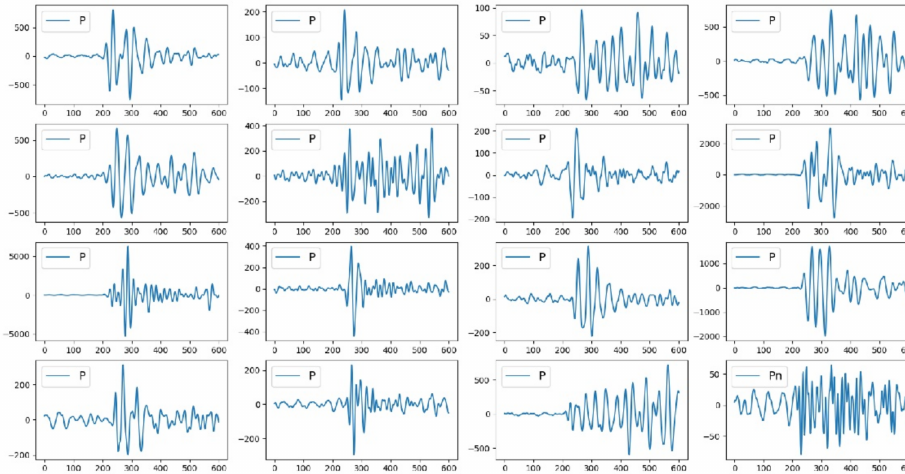
Figure 4. Beamforming data of different